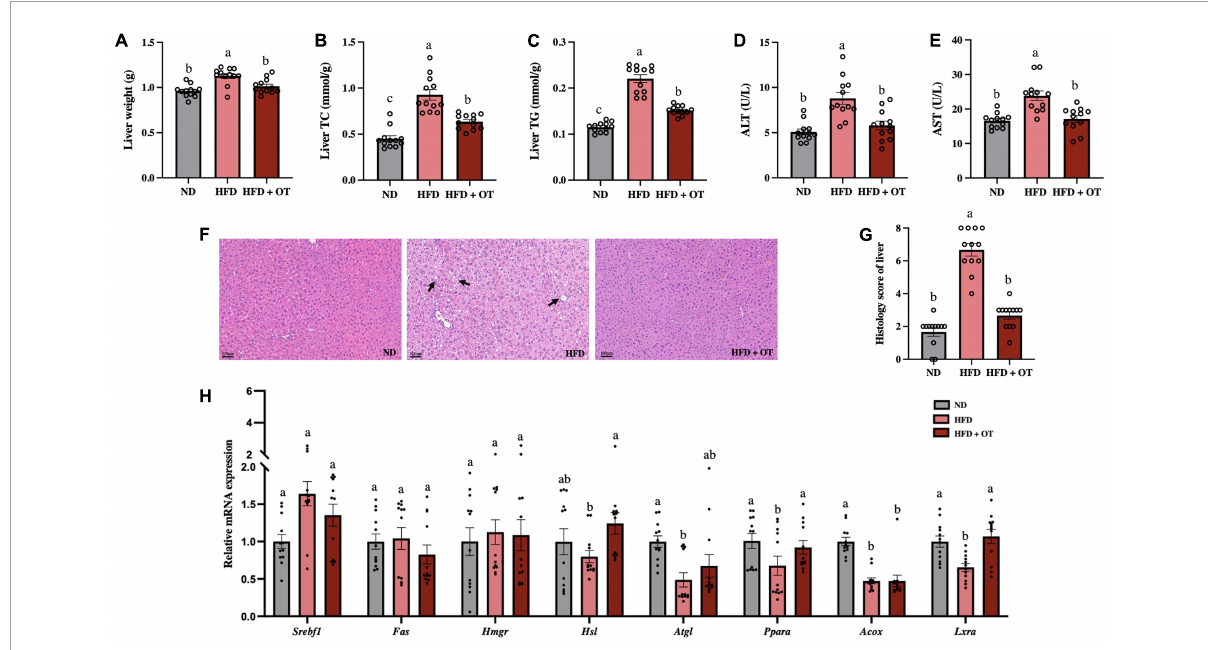
FIGURE3 Oolong tea ameliorated fatty liver and impaired hepatic function in HFD-fed mice. (A) Liver weight. (B) Liver TC. (C) Liver TG. (D) Serum ALT levels. (E) Serum AST levels. (F) H&E staining of liver tissue (scale bar, 100 µ m). (G) Histology score. (H) Relative expression of Srebp1c , Fas , Hmgr , Hsl , Atgl , Ppara , Acox , and Lxra in the liver. Data are expressed as mean ± SEM ( n = 12). The mean value with different letters indicates significant differences ( p <